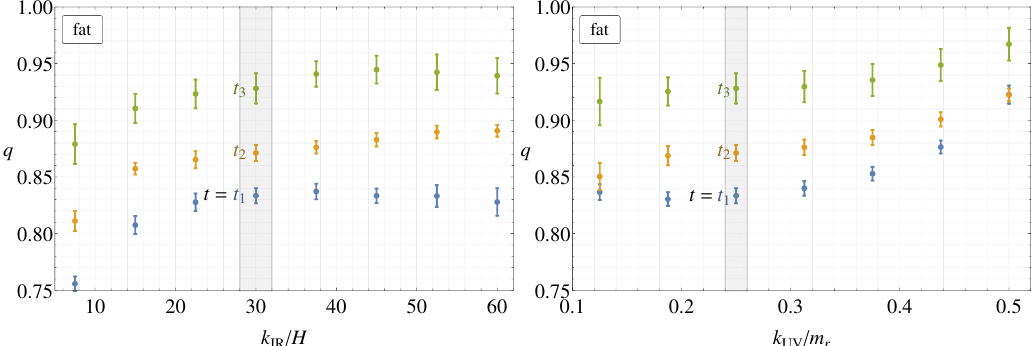
Figure 17: Left: The best fit values of q for fat strings at three different times (differ- = m / 4 fixed. Right: The best fit q with varying ent colors) for varying k , with k r IR UV = 30 H fixed. It can be seen that k = 30 H and k = m / 4 are sufficient k and k r UV IR IR UV ∆ = 1 for q to have convergered to its true value. This analysis has been done for m r and the times t , t , t correspond to log = 6.5,7,7.5. 1 2 3